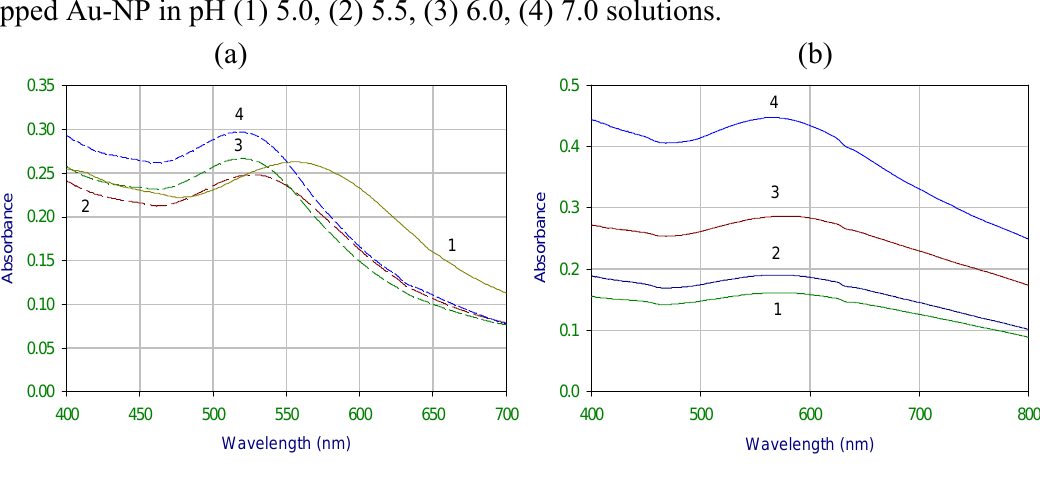
Figure 3. UV-Visible spectrum of (a) glutathione capped Au-NP, and (b) lipoic acid capped Au-NP in pH (1) 5.0, (2) 5.5, (3) 6.0, (4) 7.0 solutions.